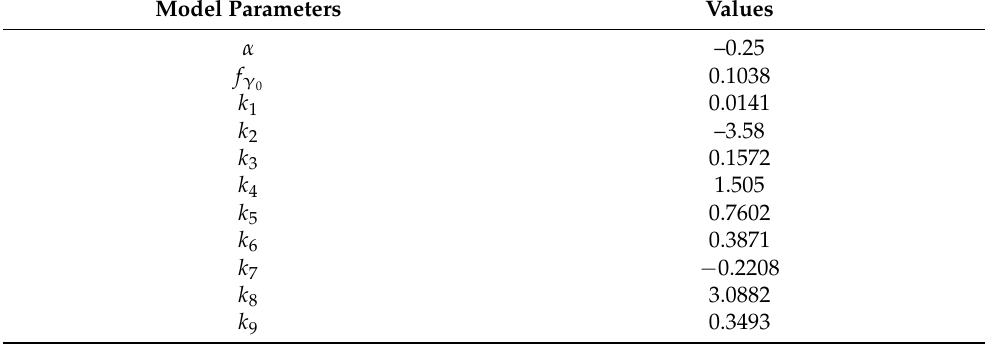
sheets under various stress states using calibrated parameters, as illustrated in the solid lines in Figure 6.